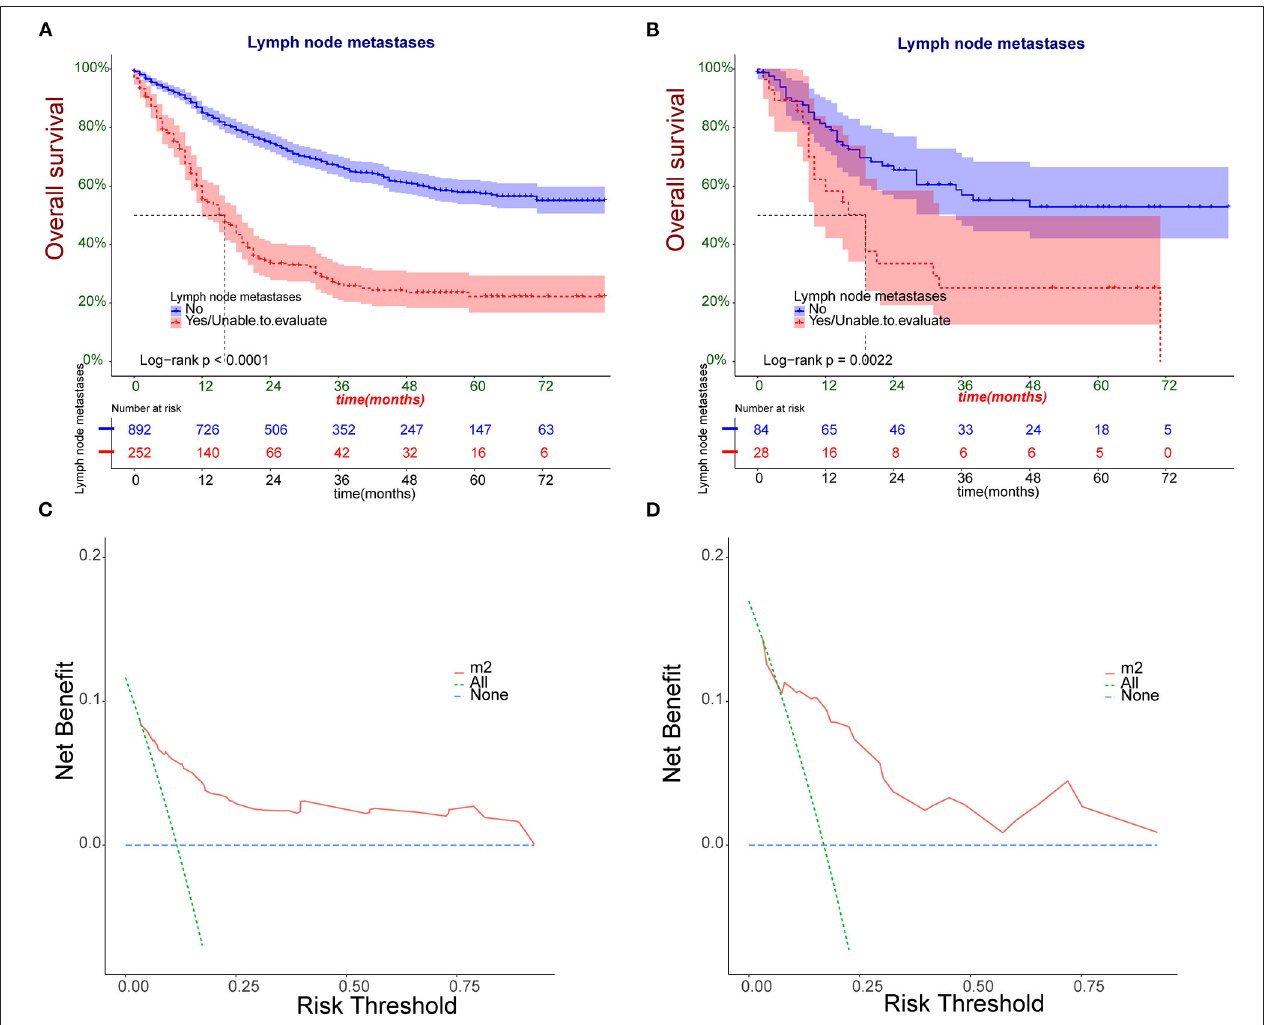
FIGURE 3 | (A,B) The Kaplan-Meier survival analysis patients with osteosarcoma in training and validation group. (C,D) Nomogram decision curve (DCA) of the training and validation